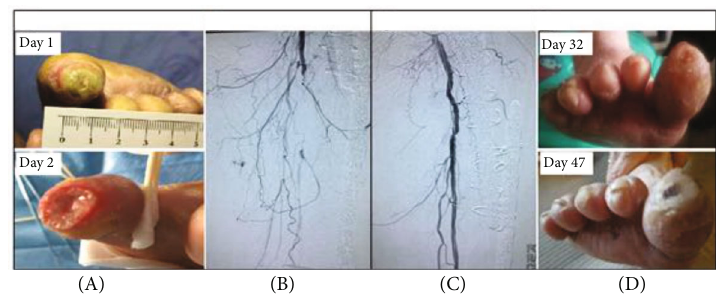
Figure 1: Lower limb salvage with revascularization in diabetic chronic limb-threatening ischemia.